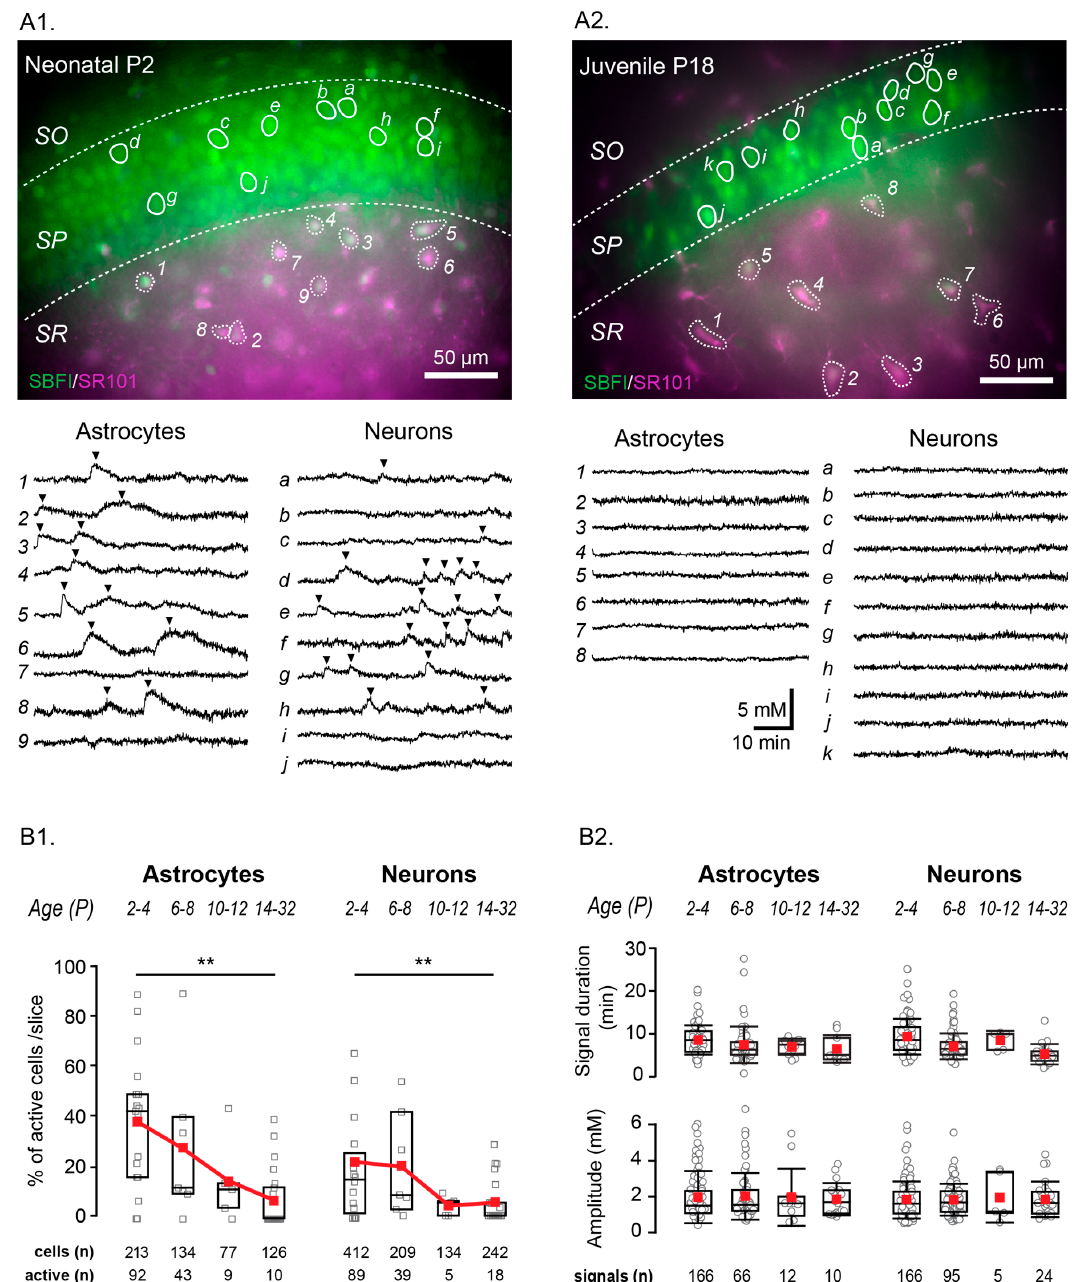
Figure 3. Age dependence of spontaneous Na + fluctuations. Example merged staining of a P2 ( A1 ) and P18 ( A2 ) hippocampal slice (SBFI in green, SR101 in magenta, overlapping regions in white) with example cells encircled and their individual fluorescent measurement traces shown below. Analyzed fluctuations are indicated by black arrows. Scale bars show 50 µm. SO, SP, SR: stratum oriens, pyramidale, and radiatum, respectively. ( B1 ) Box plots illustrating the decline in the percentage of cells showing activity per slice with increasing mouse age. ( B2 ) Properties from fluctuations in different age groups, as written above. Box-and-whisker plots indicate the median (line), mean (red square), interquartile range (box), and standard deviation (whiskers). ** 0.001 ≤ p < 0.01.